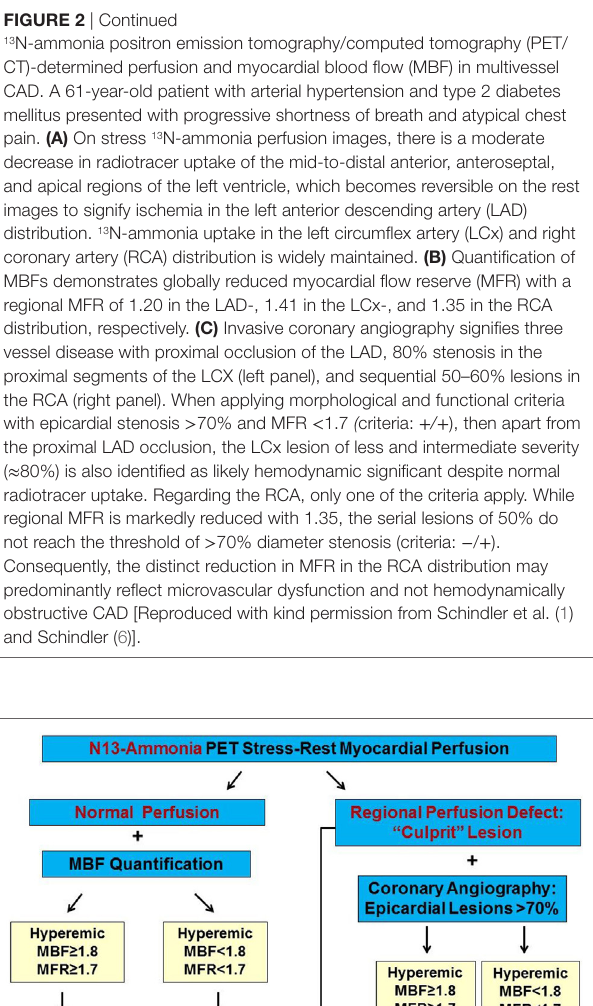
FiGURe 2 | Continued 13 N-ammonia positron emission tomography/computed tomography